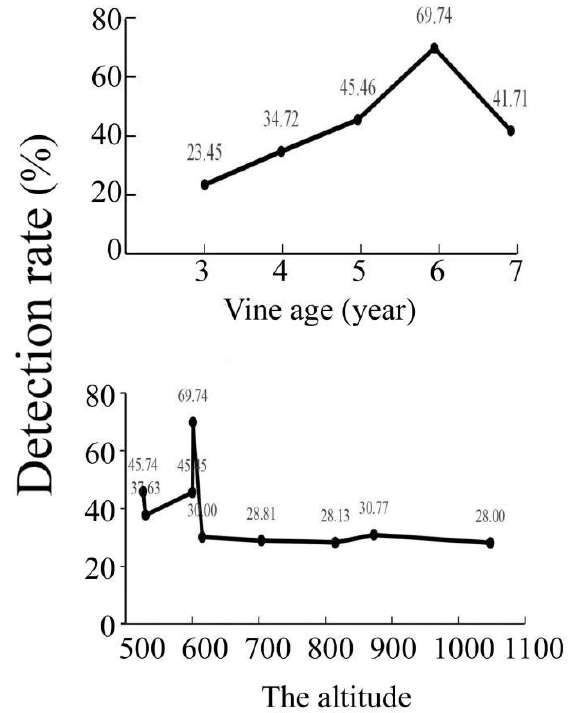
Figure 2. The virus detection rate was affected by the altitude and the vines’ age